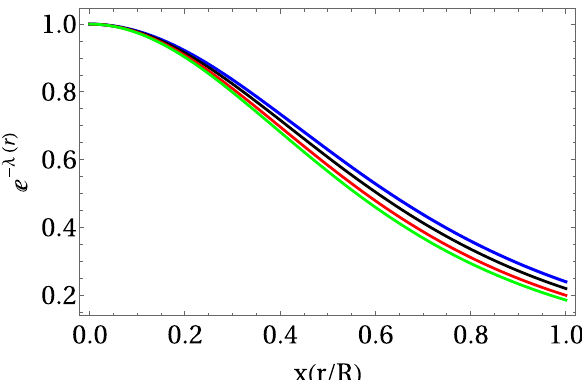
Fig. 8 Radial metric for Model II for compact factors: 0.38 (blue line), 0.39 (black line), 0.40 (red line) and 0.407 (green